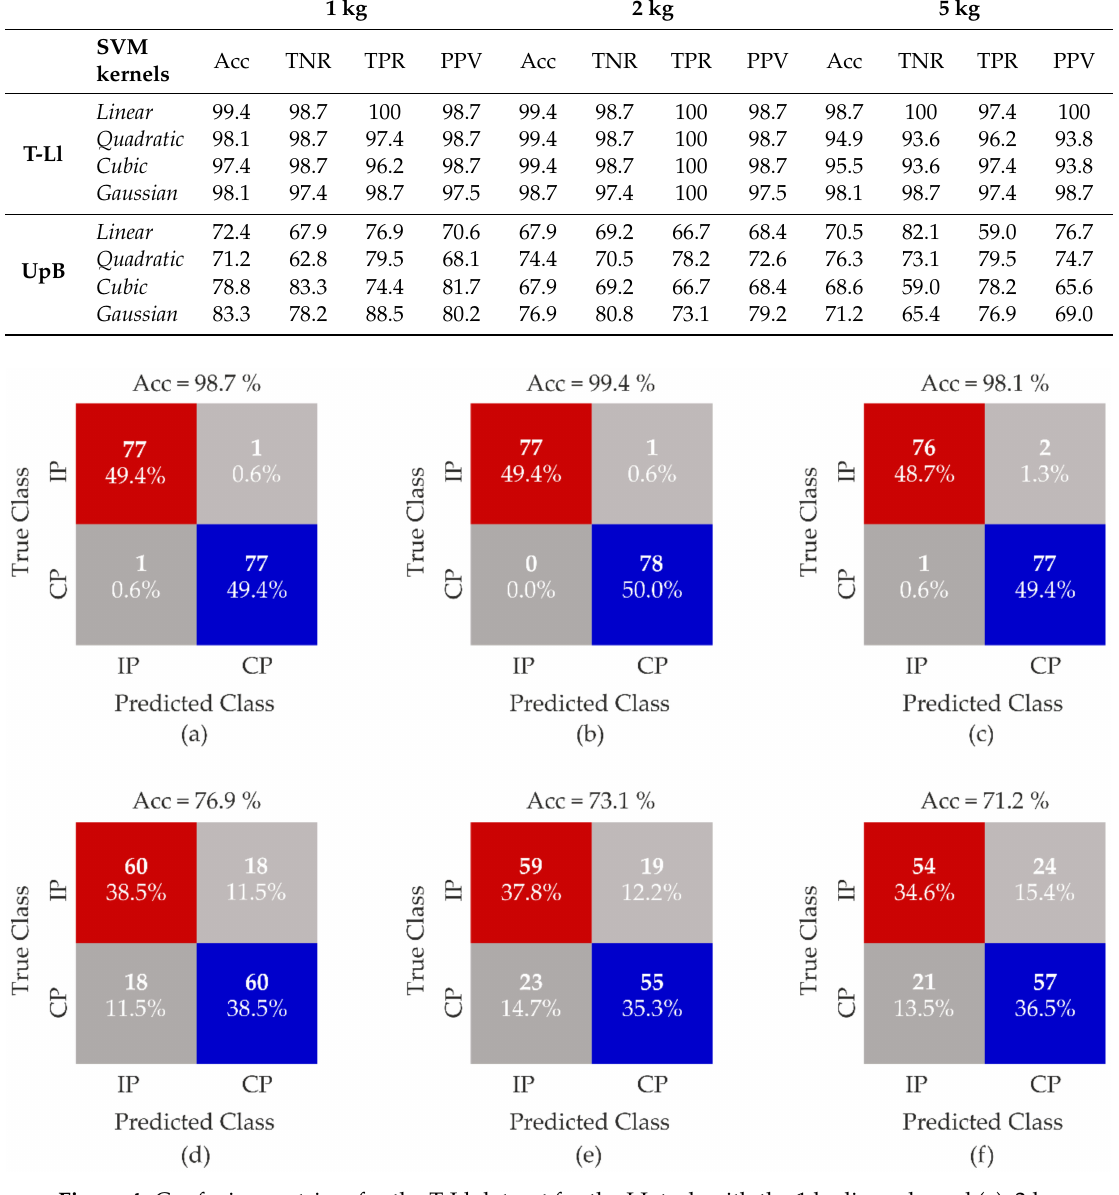
Figure 4. Confusion matrices for the T-Ll dataset for the LL task with the 1 kg linear kernel ( a ), 2 kg quadratic kernel ( b ) and 5 kg linear kernel ( c ) loads; and the UpB dataset for the LL task with the 1 kg quadratic kernel ( d ), 2 kg Gaussian kernel ( e ) and 5 kg linear kernel ( f ). IP = incorrect Posture and CP = correct